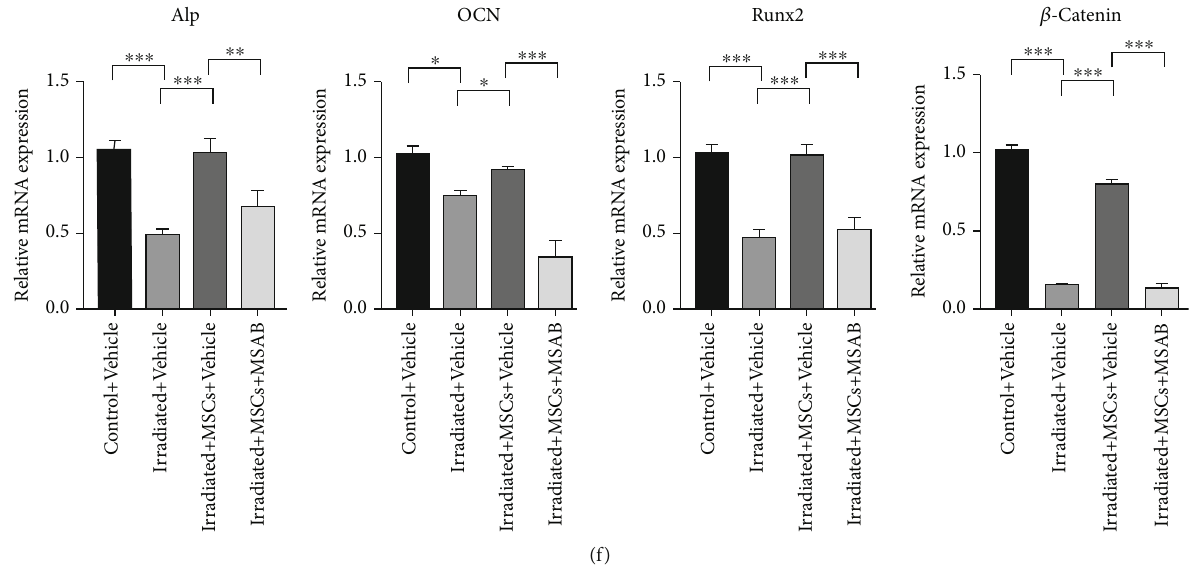
Figure 3: hUCB-MSCs can regulate osteogenic di ff erentiation of damaged cells through Wnt/ β -catenin. (a) Western blot to detect the expression of apoptosis markers in control, MSC treatment, and irradiated MC3T3. (b) Western blot to detect the expression of osteogenic di ff erentiation markers in control, MSC treatment, and irradiated MC3T3. (c) The expression of osteogenic di ff erentiation- speci fi c genes in MC3T3 of control, irradiated, and irradiated with MSC treatment. (d) Alizarin red staining in control, irradiated, irradiated with MSCs, and irradiated with MSCs and MSAB MC3T3. (e) Statistics of Alizarin red staining in control, irradiated, irradiated with MSCs, and irradiated with MSCs and MSAB MC3T3. (f) The expression of osteogenic di ff erentiation-speci fi c genes in MC3T3 of control, irradiated, irradiated with MSCs, and irradiated with MSCs and MSAB. All data are mean ± SD ; ∗ P < 0 : 05, ∗∗ P < 0 : 01 , and ∗∗∗ P < 0 : 001